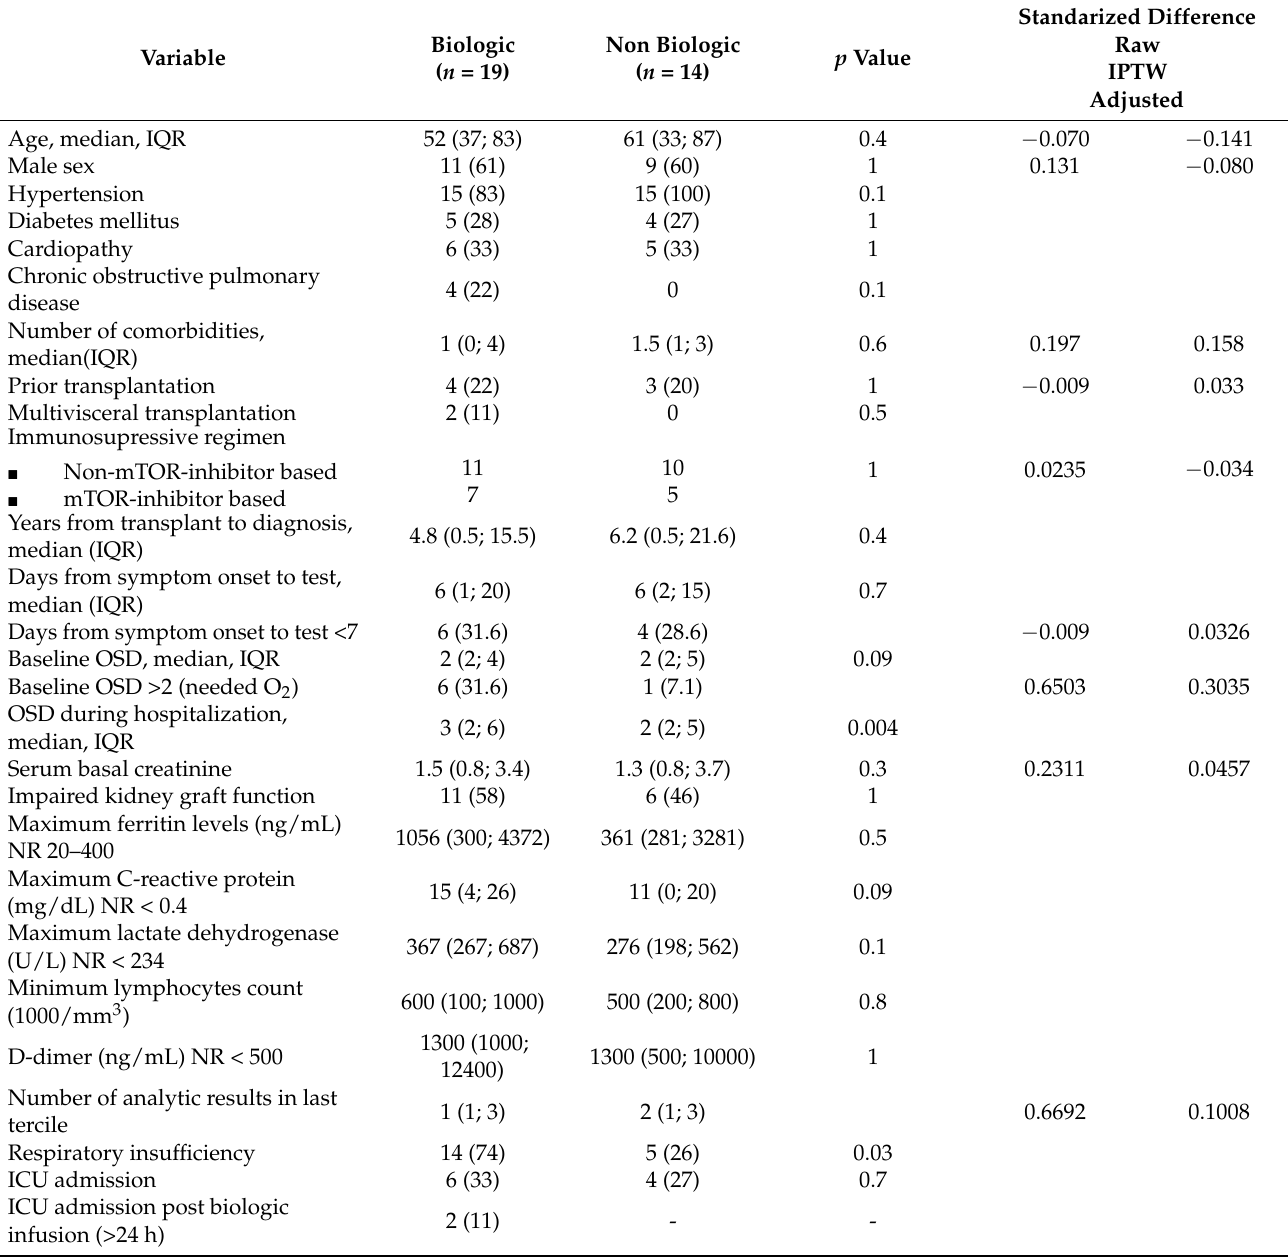
Table 2 shows the description of baseline characteristics of patients stratified by bio- logic prescription and clinical presentation of kidney transplant recipients with COVID-19. Standardized differences showed baseline heterogeneity between both groups for number of analytical results in last tercile. Biologic treatment was prescribed more frequently in patients presenting with respiratory insufficiency compared with those with no respiratory insufficiency (74% vs. 26%). Six patients required ICU admission in the biologic group (33%). Two of these patients required ICU admission >24 h after biologic infusion, but none of them required invasive mechanical ventilation. No immediate drug-related side effects such as severe neutropenia, thrombocytopenia or hepatitis were reported. Table 2. Baseline characteristics and clinical presentation of kidney recipients with COVID-19 by biologic therapy prescription and standardized difference depending on before and after application of inverse of probability of treatment weighting (IPTW) in the